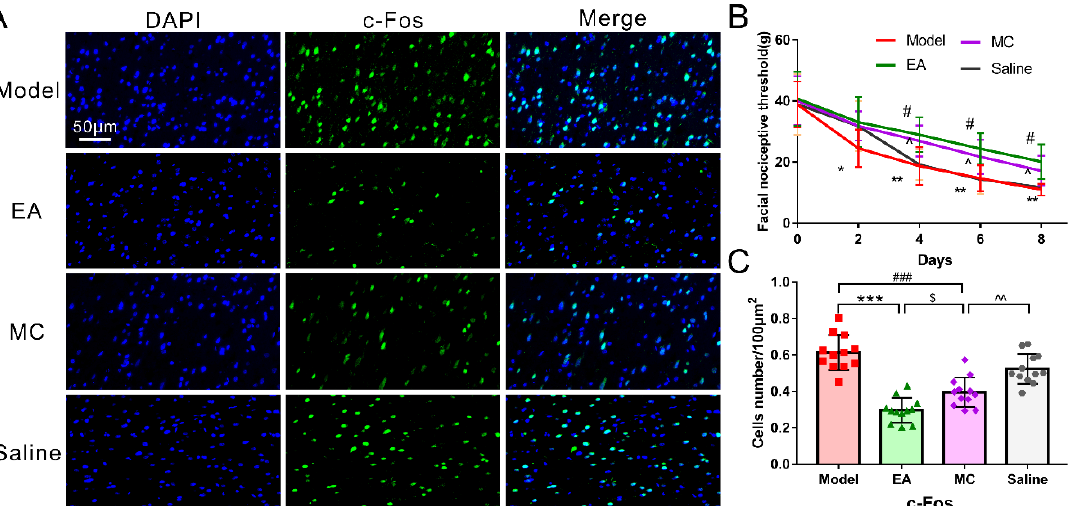
Figure 7. The acupuncture-like role of minocycline in the migraine central sensitization. ( A ) Images of c-Fos-immunoreactive neurons in TNC in each experimental group (400×, Scale bar = 50 µm). ( B ) Facial nociceptive threshold among groups ( n = 10). ( C ) The density of c-Fos positive neurons in TNC in each experimental group ( n = 4, three sections/rat). One-way ANOVA followed by post hoc Tamhane test. Data are mean ± SD, * p < 0.05, ** p < 0.01, *** p < 0.001, model versus EA. $ p < 0.05, EA versus MC. # p < 0.05, ### p < 0.001, MC versus model. ˆ p < 0.05, ˆˆ p < 0.01, saline versus MC.